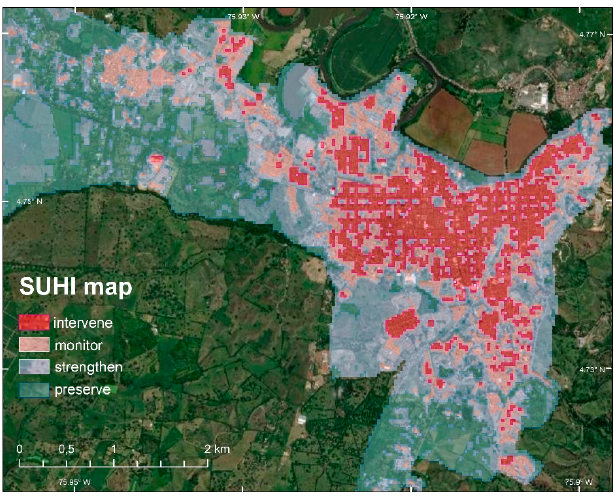
Figure 14. Final SHUI product from NBML. The legend recommendations are specific types of action based on temperature